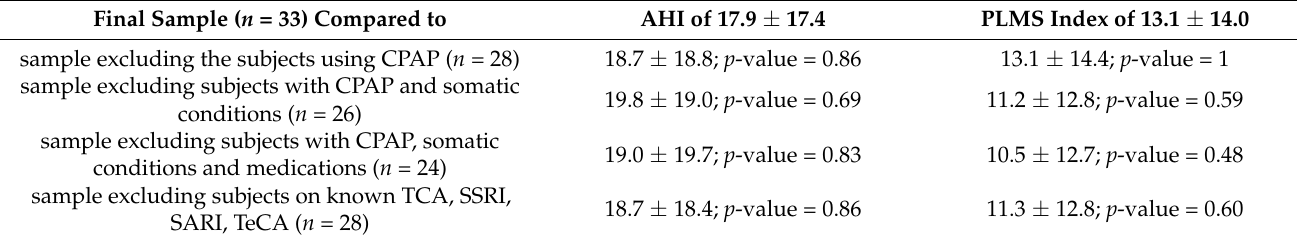
Table 6. Sensitivity analysis (mean ± sd, p